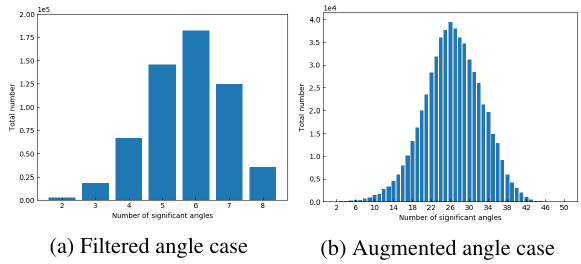
Figure 11. Number of angles in original and augmented angle representation.